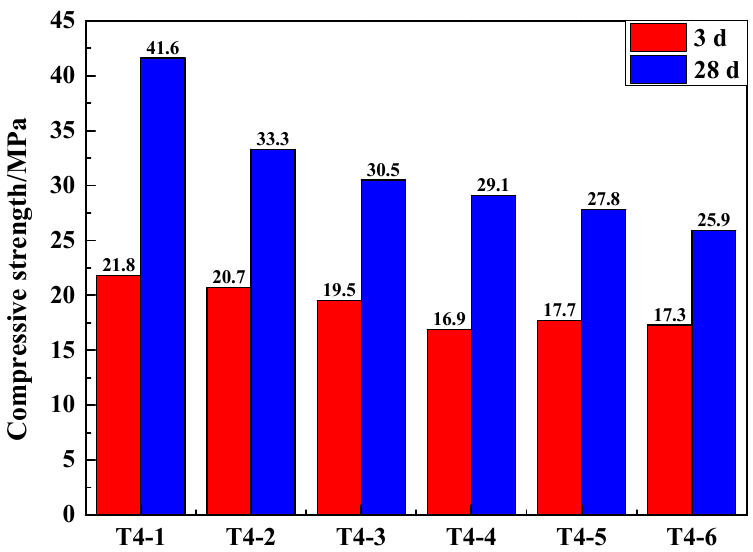
Figure 4. Compressive strength of the samples made of SSCND–cement at the ratio of 80:20 activated under different contents of gypsum and 2%Na 2 SO 4 after 3 and 28 days of curing.